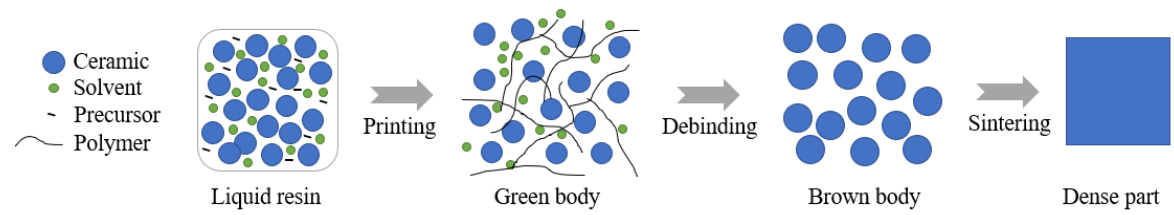
Figure 8. Scheme of the formation of dense ceramic components. Adapted from [65].